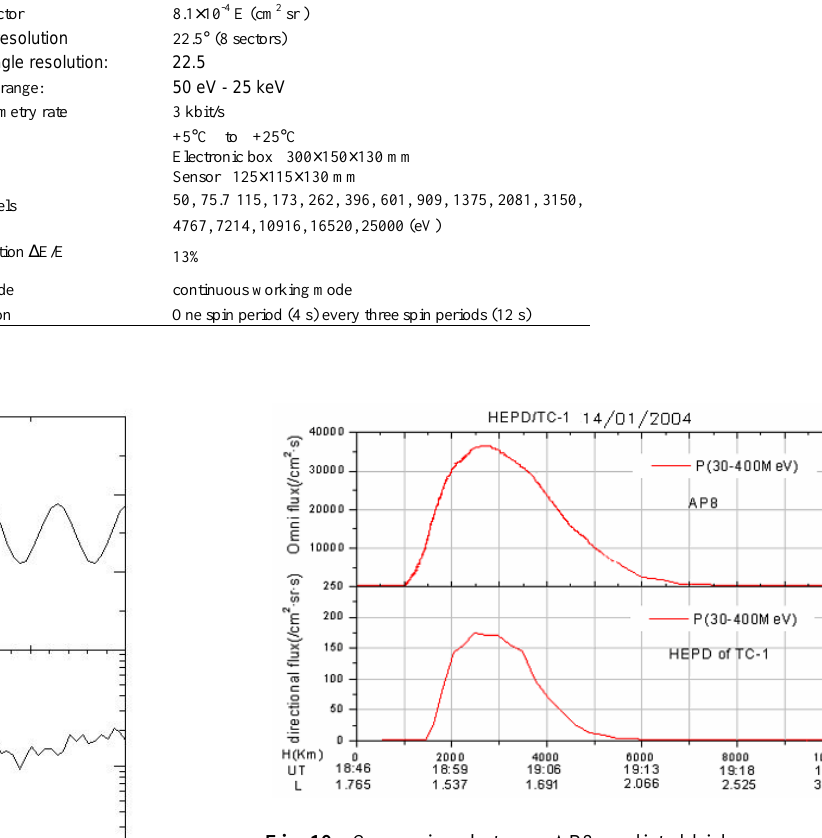
Fig. 10. Comparison between AP8-predicted high energy proton omni-flux and the directional flux of HEPD/TC-1 on 14 January 2004.